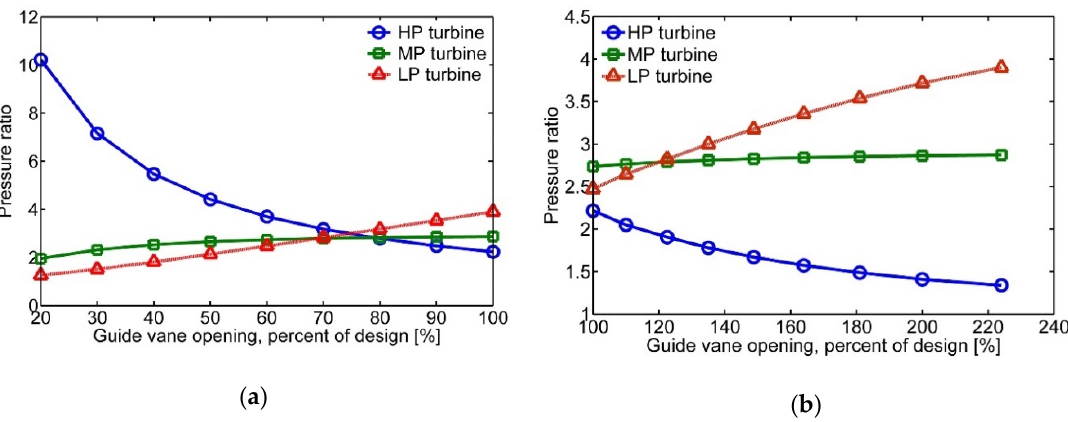
Figure 8. Variable operating conditions for a multistage radial turbine under guide vane opening change: ( a ) down-regulation at rated inlet pressure; ( b ) up-regulation at 60% the rated inlet pressure.